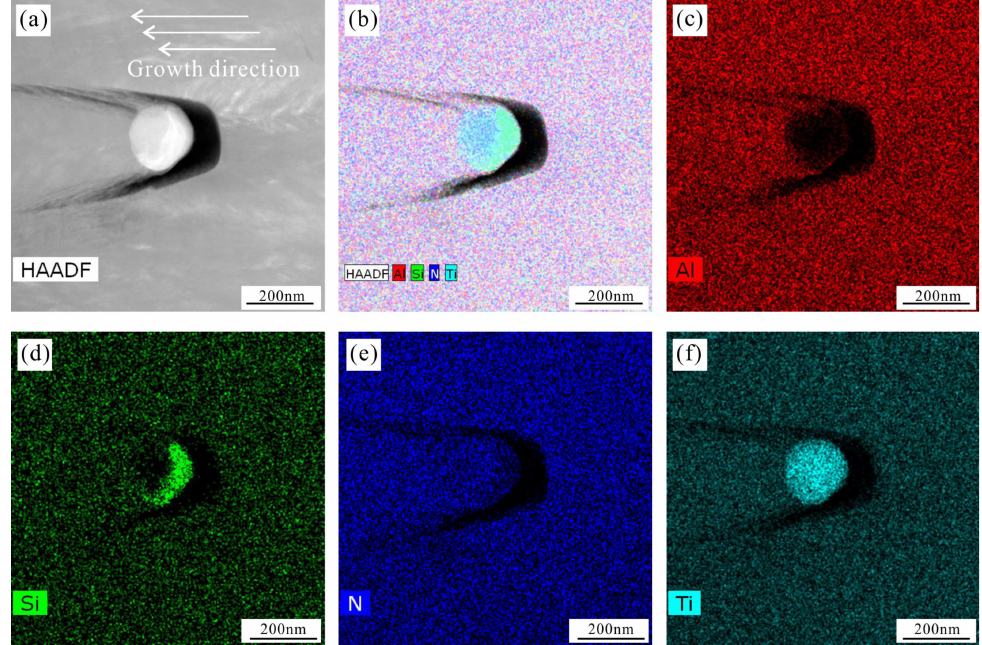
Figure 4. ( a ) HAADF–STEM image of PVD Ti 0.31 Al 0.60 Si 0.09 N coating and EDS mapping images for distribution of ( b ) Al, Si, N and Ti; ( c ) Al; ( d ) Si; ( e ) N; ( f ) Ti in PVD Ti 0.31 Al 0.60 Si 0.09 N